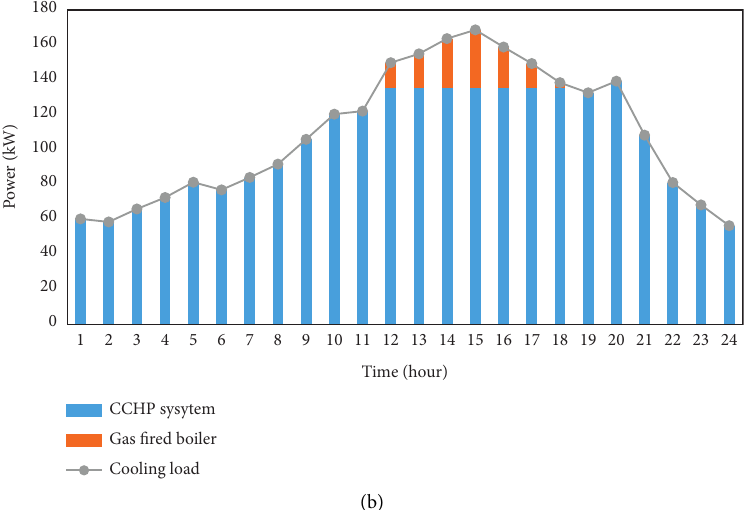
Figure 5: Optimization results with heat pump and cold storage in summer: (a) electric power and (b) cooling power.